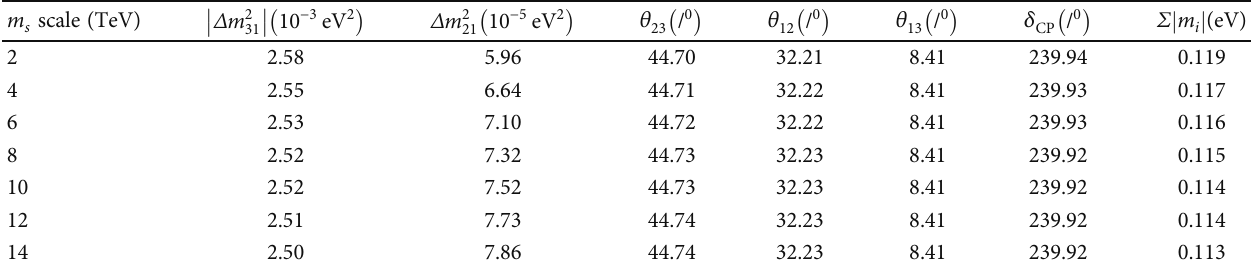
for IH case ( tan β = 40 , M s